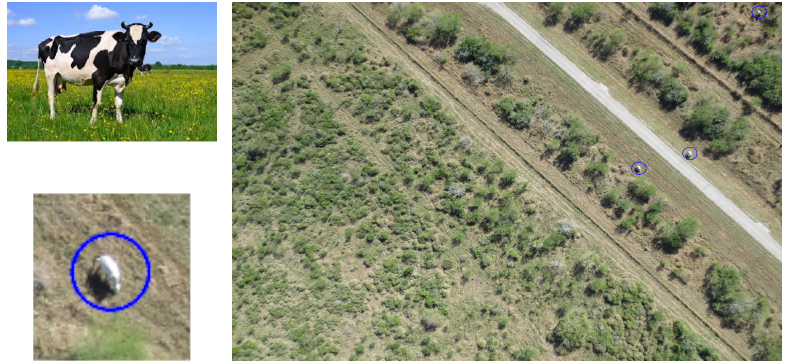
Figure 1. The difference between front-view of an object in typical ground-based human-centric photograph ( Top Left ) and top view in aerial images ( Right; Bottom Left ); Objects in aerial images are small, flat, and sparse; moreover, objects and backgrounds are highly imbalanced. In human-centric photographs, different parts of objects (head, tail, body, legs) are clearly observable while aerial imagery present very coarse features. In addition, aerial imagery presents argumentative features, such as